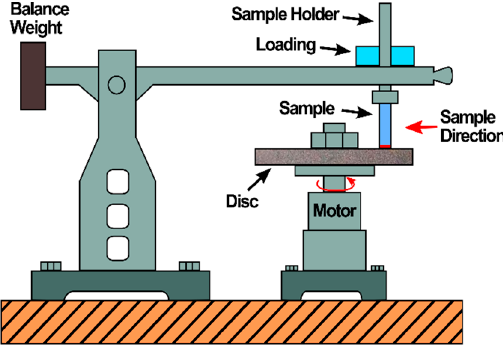
Figure 2. Schematics of AGP ‐ 1 abrasive wear test.